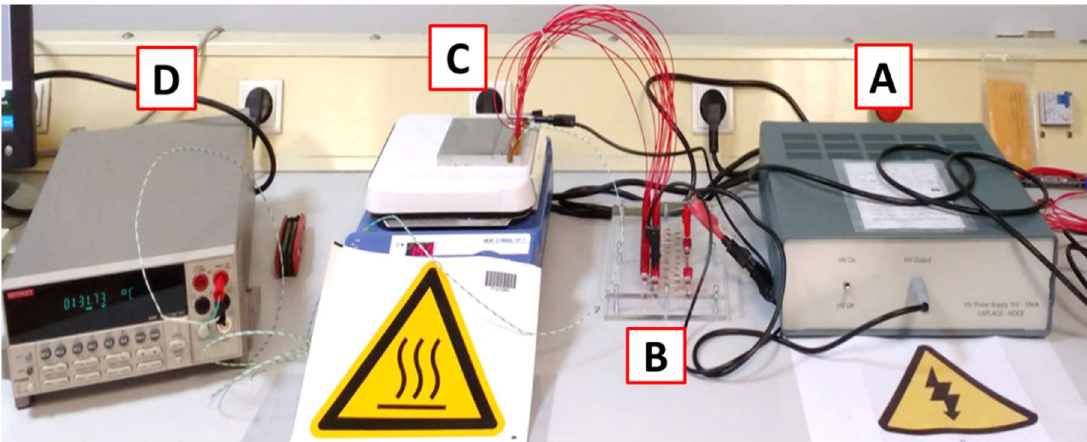
Figure 3. System for performing HALT on multiple samples at once. ( A ) HV power supplier (1 kV–10 mA); ( B ) Plate with protective resistors in parallel to connect the samples that are inside ( C ), a metallic cell placed over a heating plate, the temperature of which is monitored with ( D ), a voltmeter reading the measurements of a thermocouple (K-type).